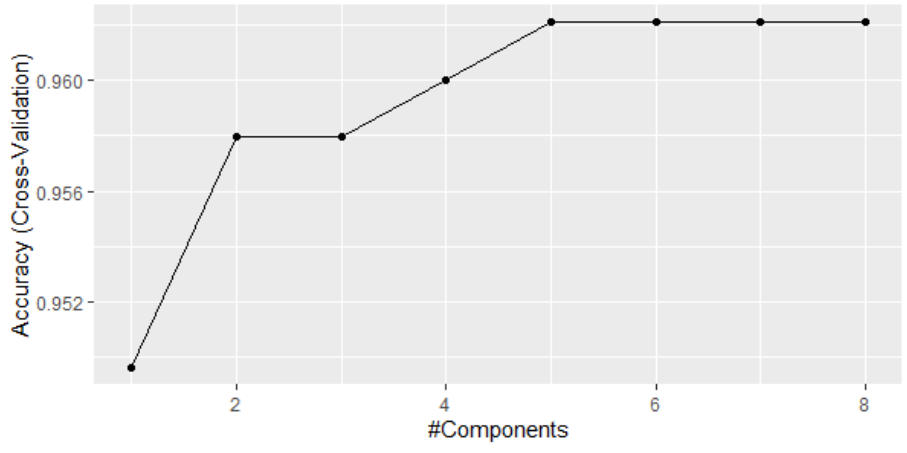
Figure 16. Selecting the number of components by CV for the breast cancer